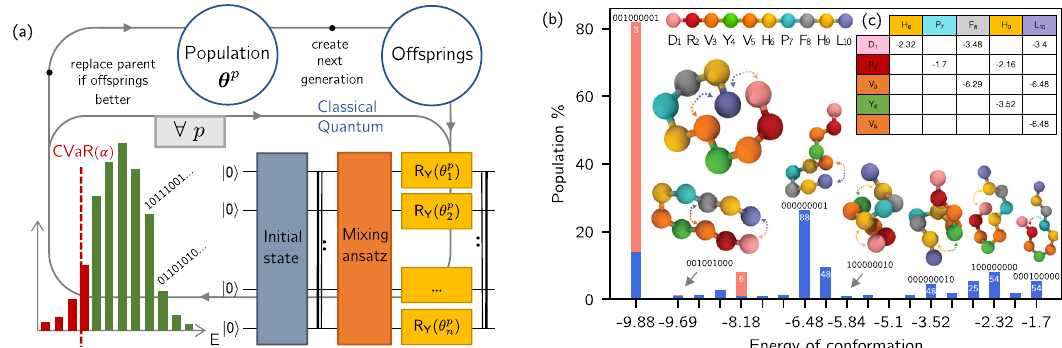
Fig. 2 Schematic representation of the folding algorithm and folding process. a Starting from a random population (up-center) of circuit parameters { θ }, every parent, θ p , undergoes a parametrized recombination with other individuals according to the procedure detailed in Section “ Methods ” . The corresponding trial wavefunctions are generated in the quantum circuit as described in the main text and measured to estimate the new CVaRs. They determine the selection criteria of whether to replace a parent by its offspring for the new generation. b Folding of the ten amino acid Angiotensin peptide. Energy distribution at the convergence of the low-energy folds for the population obtained with the CVaR-VQE algorithm and the DE optimizer. The results were obtained using 128 (blue) and 1024 measurements (orange). Simulations were carried out using a realistic parametrization of the noise. The binary strings (q 1,6 q 1,8 q 1,10 q 2,7 q 2,9 q 3,8 q 3,10 q 4,9 q 5,10 ) associated with the different bars represent the contact qubits (see text) that entirely de fi ne the conformation energies. The numbers labeling the bars correspond to the exact degeneracy of the conformations. The total probabilities of fi nding low-energy conformations (energy below 0) adds up to 89.5% (small sampling, blue) and 100% (large sampling, orange). The fi ttest individual in the population collapses to the ground state with a probability of 42.2% (Supplementary Methods, Fig. 2). c Primary sequence of Angiotensin. To each amino acid is assigned a color that characterizes its speci fi c physical properties. The letters stand for Aspartic-Acid (D), Arginine (R), Valine (V), Tyrosine (Y), Histidine (H), Proline (P), Phenylalanine (F), and Leucine (L). d Pairwise interaction matrix for Angiotensin constructed using the MJ model (Table 3 in 17